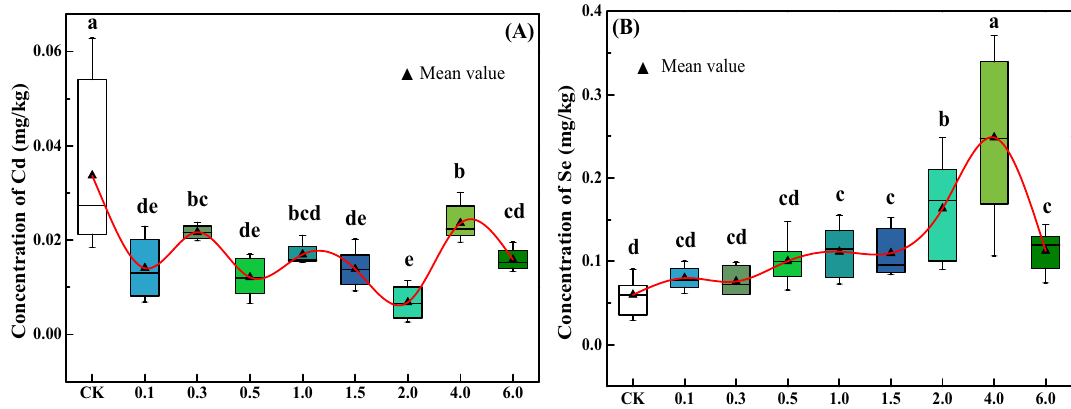
Figure 1. Box plots of Cd ( A ) and Se ( B ) concentrations in roots of M. oleifera . Boxes with different lowercase letters indicate significant differences in the mean between different treatments ( p <